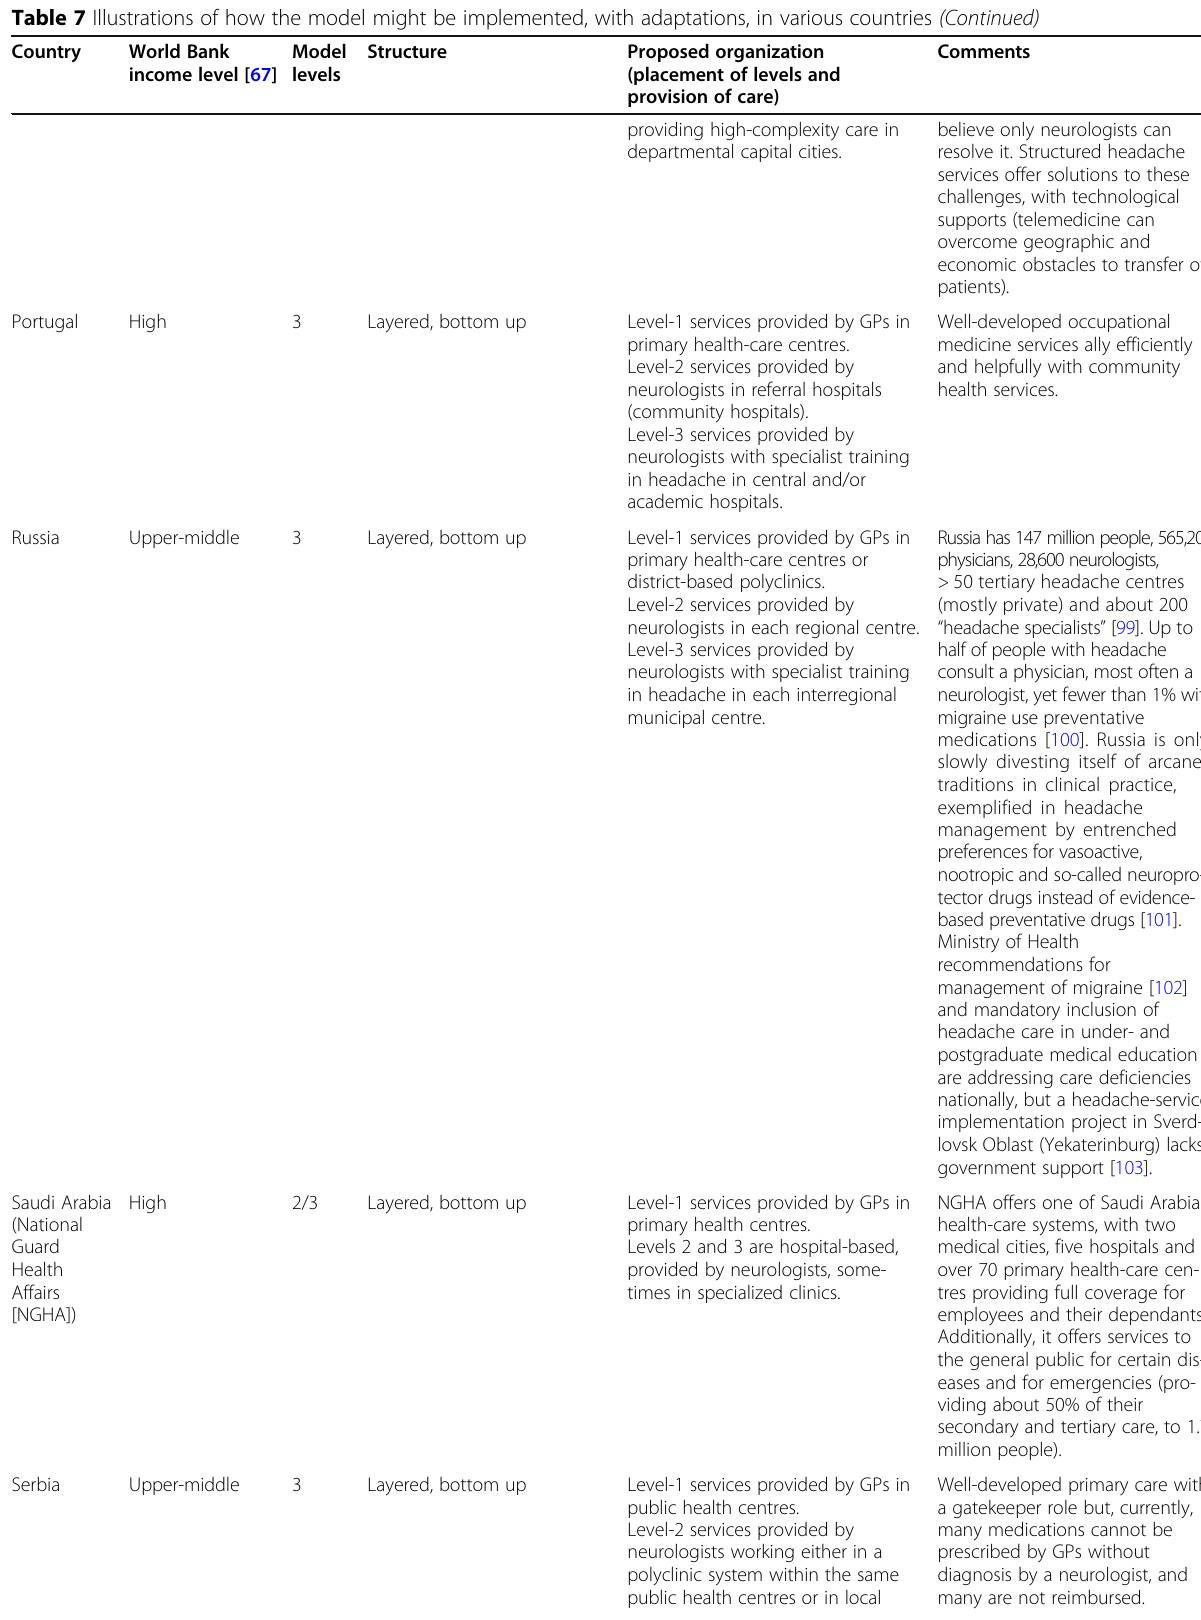
Table 7 Illustrations of how the model might be implemented, with adaptations, in various countries (Continued)